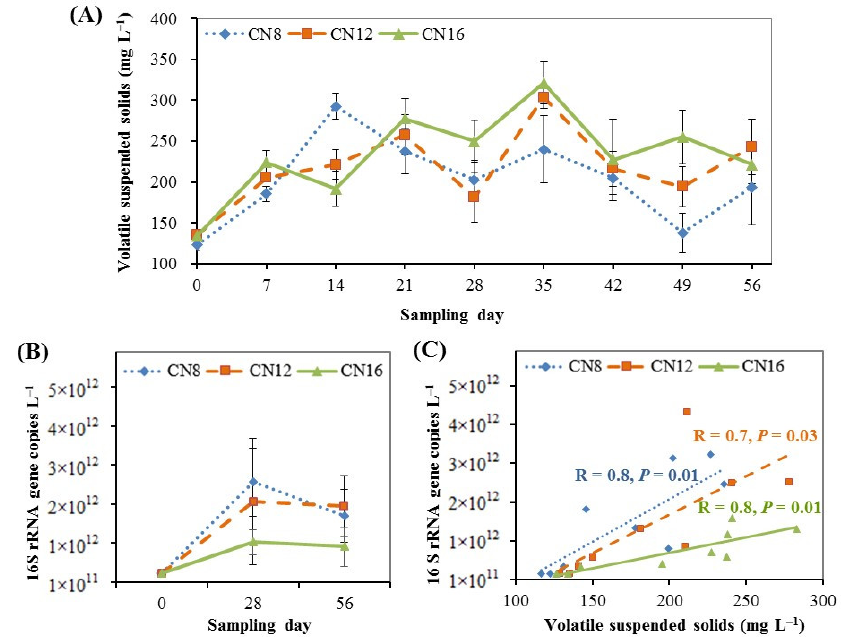
Figure 3. Changes and relations of microbial biomass and bacterial density in water biofloc from biofloc-based tank systems during an 8-week intensive production trial of P. vannamei with three input C/N ratios (means ± S.D., n = 3): ( A ) Change of microbial biomass of water biofloc; ( B ) Change of bacterial density of water biofloc; ( C ) Linear correlation between microbial biomass and bacterial density of water biofloc.